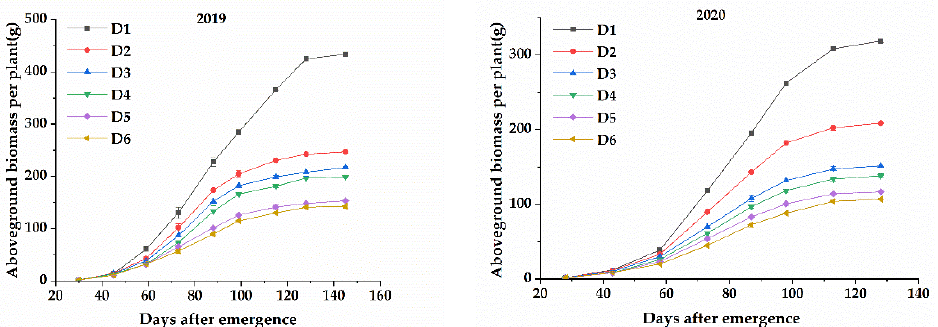
Figure 4. The aboveground biomass of a single cotton plant grown at different planting densities in 2019 and 2020.